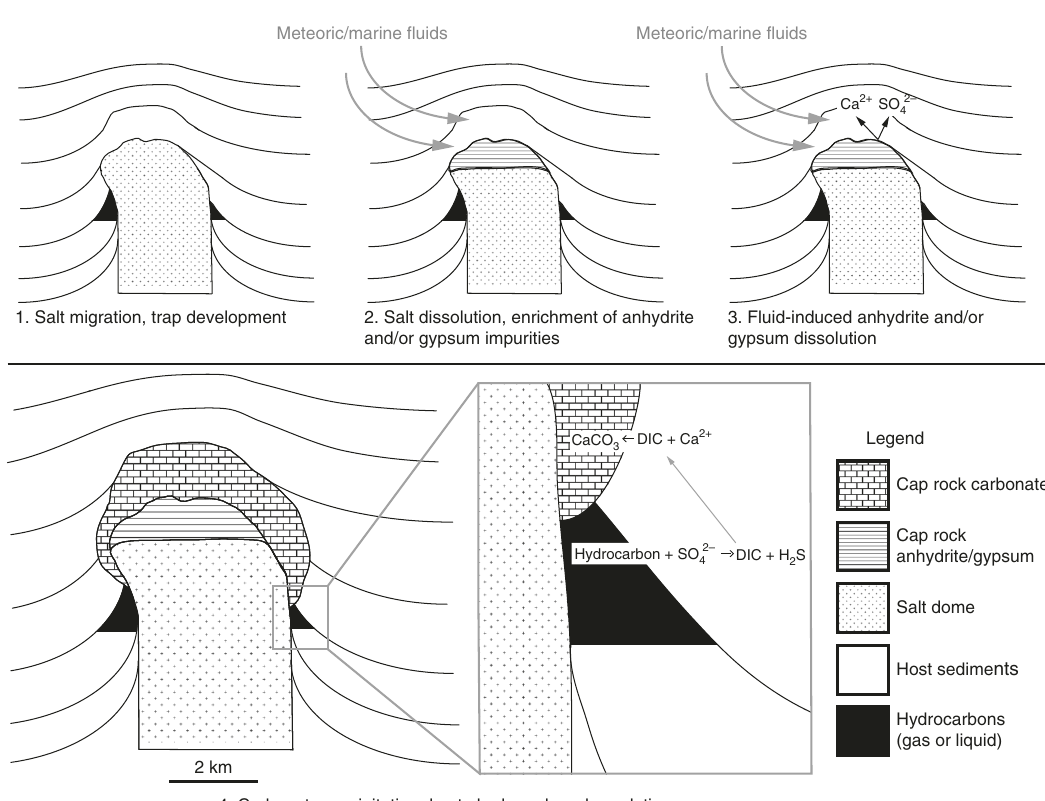
Fig. 3 Proposed paragenetic evolution of Gulf of Mexico Basin cap rock. The speci fi c nature of degraded hydrocarbon is largely uncharacterized, as is the relationship between degradation pathway and carbonate authigenesis (see step